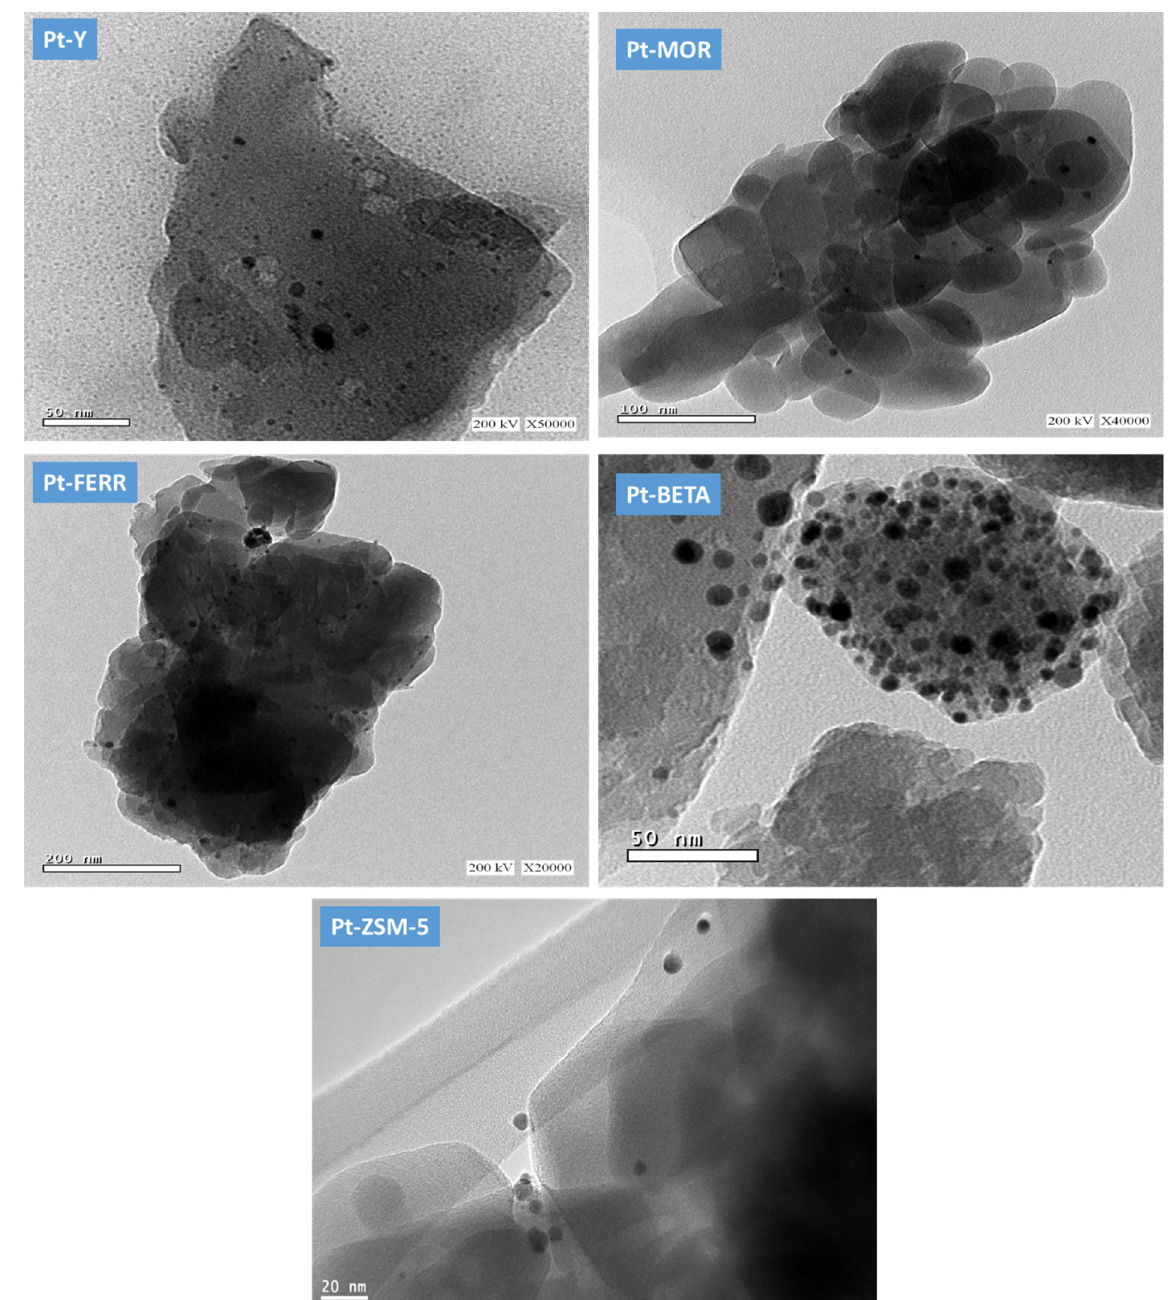
Figure 6. HR-TEM micrographs for Pt-incorporated different zeolite